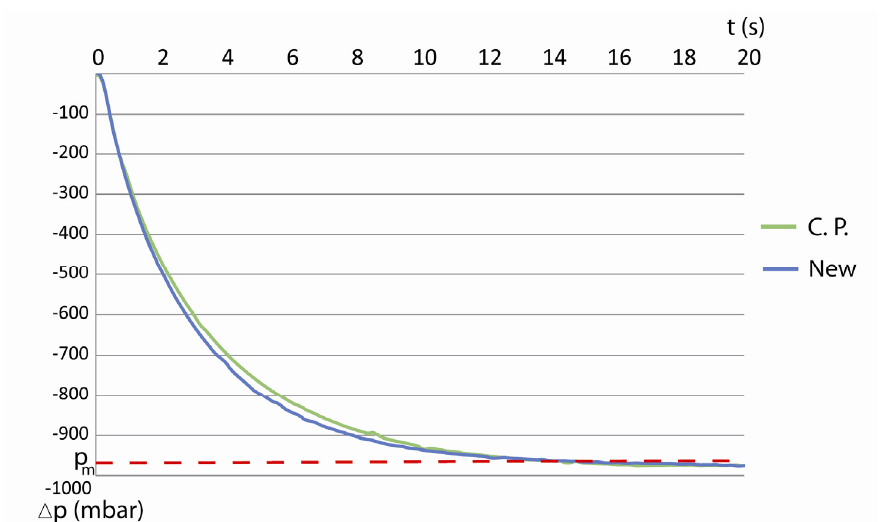
Figure 1: Power-brake booster chamber pressure profile.